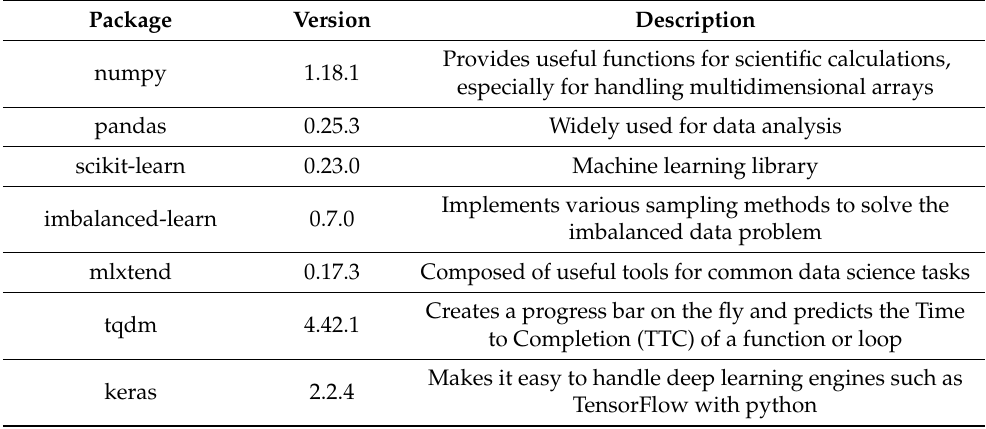
Table 5. Python libraries used for the